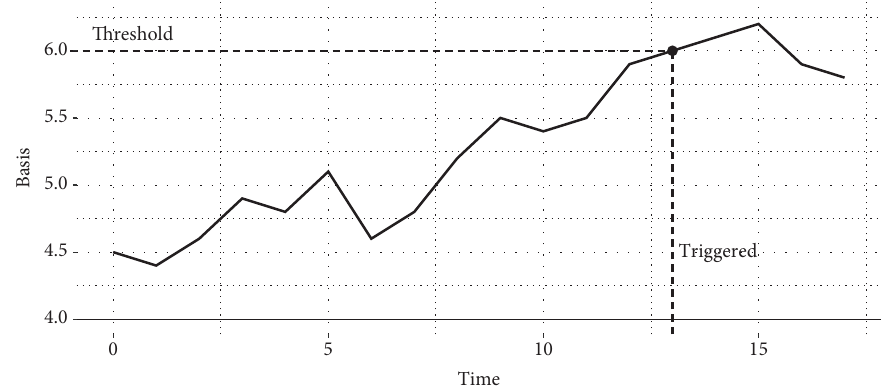
Figure 1: Trigger switches on if the basis exceeds the given